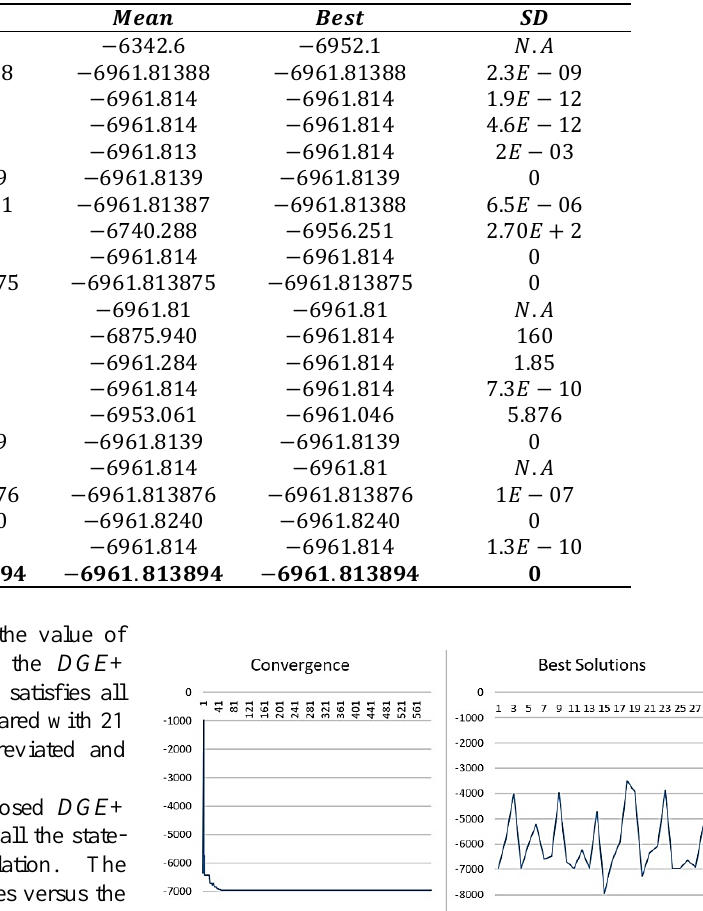
Table 9. Statistical comparison of results for constrained problem 5 of various algorithms